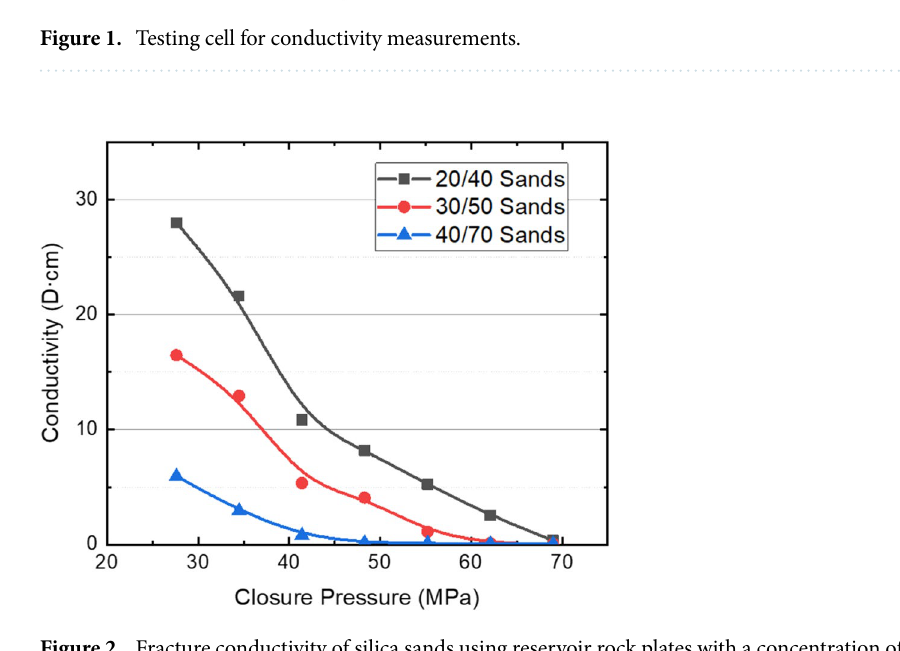
Figure 2. Fracture conductivity of silica sands using reservoir rock plates with a concentration of 8 kg/m 2